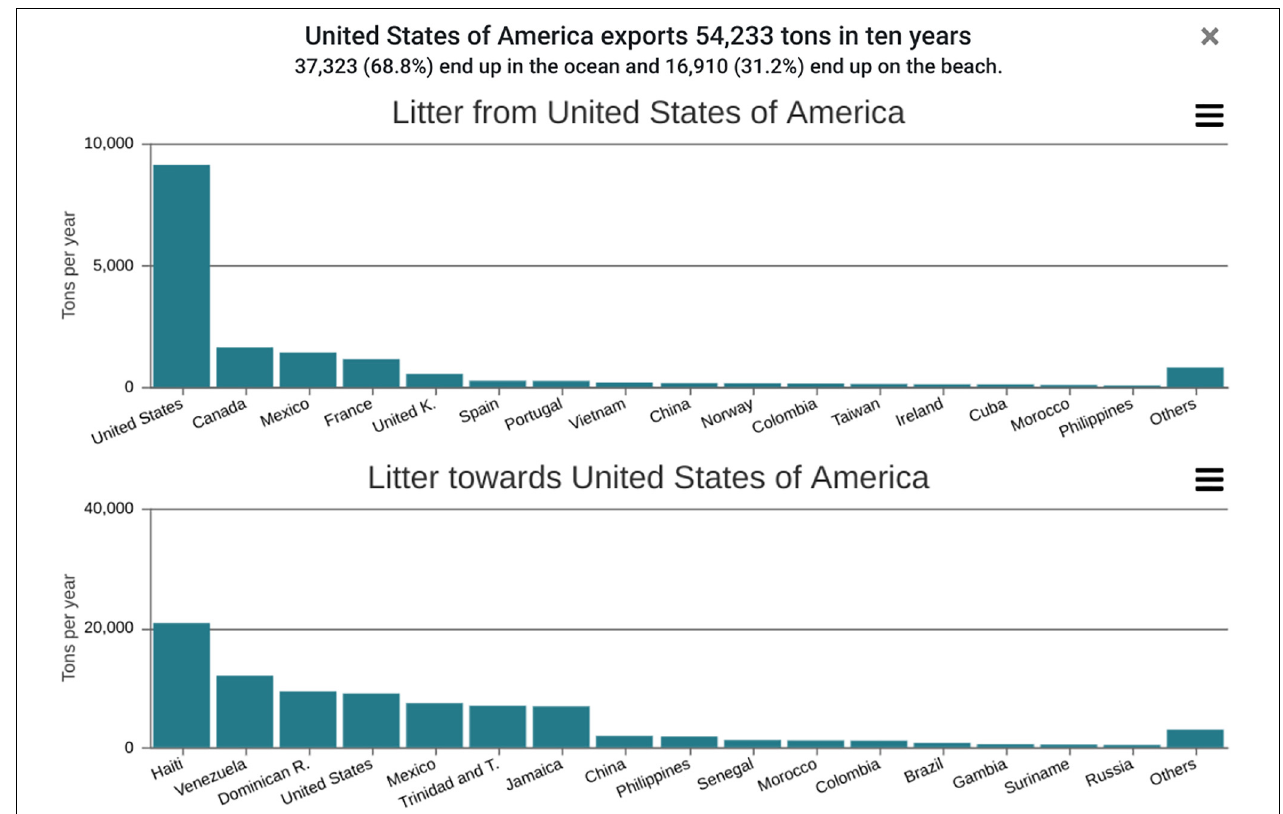
FIGURE 10 | Ocean litter statistics for the United States, as shown on the web